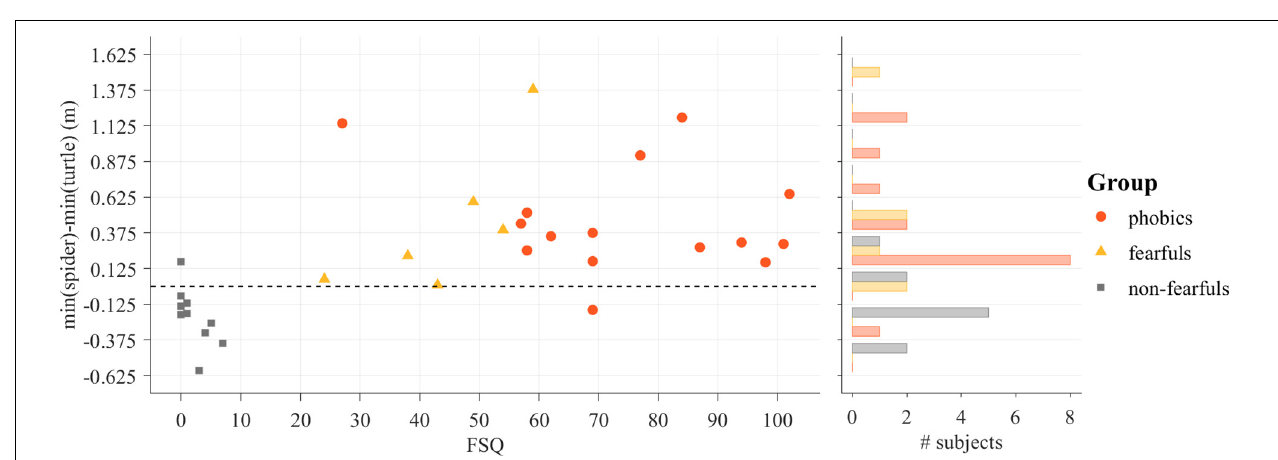
FIGURE 3 | The result of the Fishing task dependent on the Fear of Spiders Questionnaire (FSQ) score (left) and accumulated in a histogram (right).